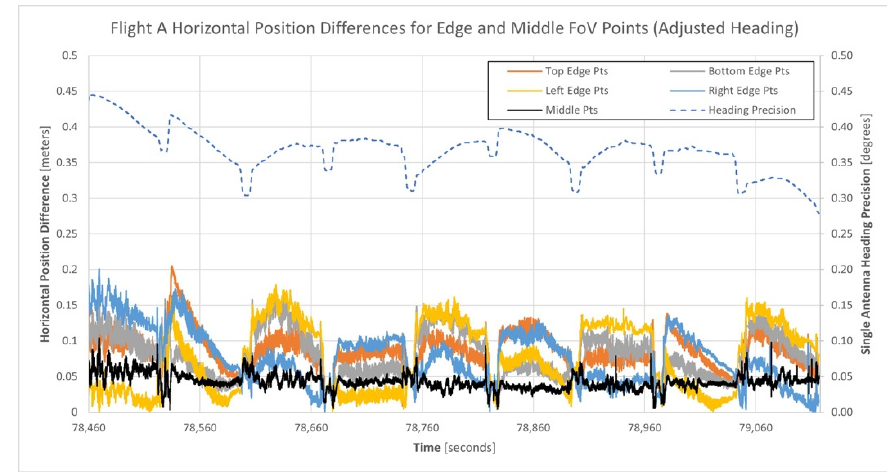
Figure 15. Horizontal position differences between the single and dual-antenna generated point clouds for the five regions of points of flight A after adjusting for the heading bias.